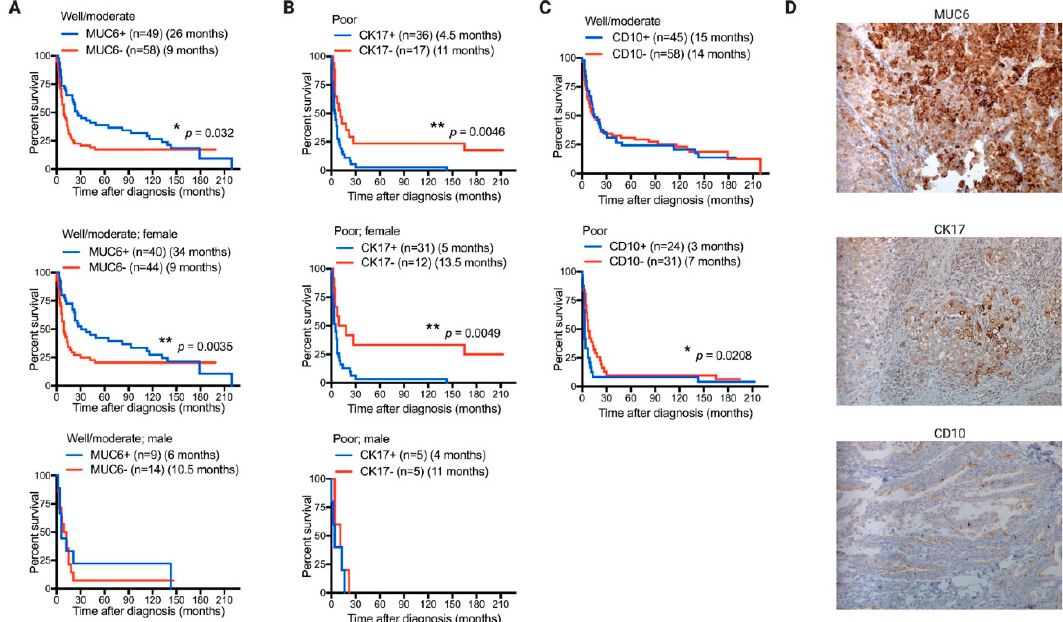
Figure 2. MUC6, CK17, and CD10 tumor expression correlate with the overall survival of GBC patients. Kaplan–Meier postdiagnosis overall-survival (OS) estimation of GBC patients according to tumor expression pattern for MUC6 (( A ) upper, patients with well- to moderately differentiated tumors; ( A ) middle, female patients with well- to moderately differentiated tumors; and ( A ) bottom, male patients with well- to moderately differentiated tumors); CK17 (( B ) upper, patients with poorly differentiated tumors; ( B ) middle, female patients with poorly differentiated tumors; and ( B ) bottom, male patients with poorly differentiated tumors); and CD10 (( C ) upper, patients with well- to moderately differentiated tumors and ( C ) bottom, patients with poorly differentiated tumors). Each graph shows the number of patients included in each group ( n ) and median OS time in months. Only p values < 0.05 shown. ( D ) Immunohistochemical representative photographs using a tissue microarray (magnification, X20), for (upper) MUC6, (middle) CK17, and (bottom) CD10.